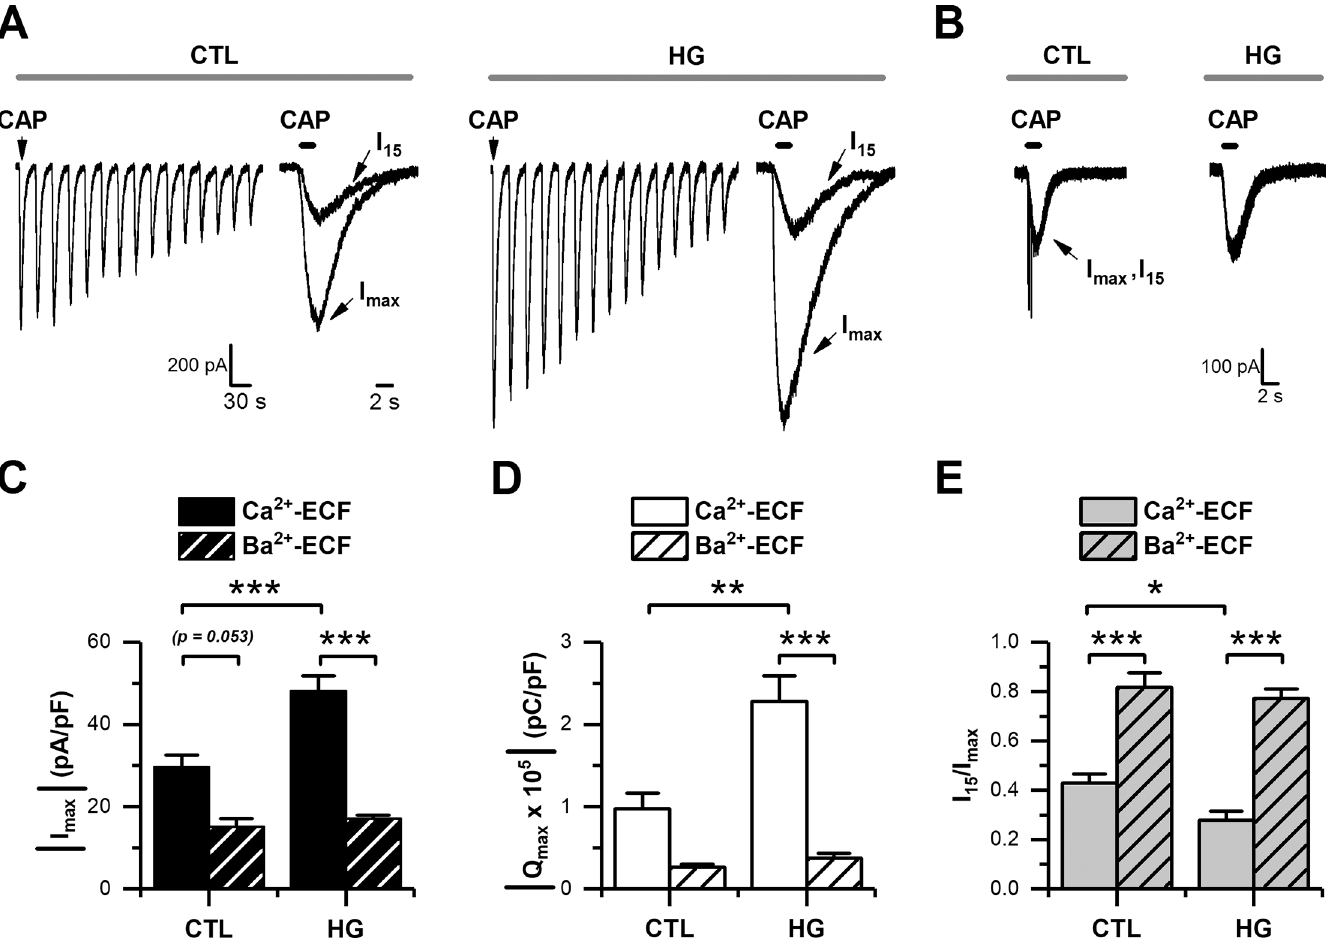
Fig 1. High glucose potentiated CAP-evoked currents in cultured DRG neurons. A-B, representative traces of CAP-evoked currents recorded in whole-cell voltage- clamp mode (holding potential set at -60 mV). Agonist was applied for 1 s and repeated every 30 s, in control (CTL), and high glucose (HG) in Ca 2+ -ECF (A), and in the same glucose conditions but in Ba 2+ -ECF (B), respectively. C-E, bar graphs summarizing maximal current (I max ) density (C), maximal current charge (Q max ; D), and maximal current rundown calculated as the ratio of I max relative to the 15 th application (I 15 ) in a series (E), for CTL (n = 24) and HG (n = 24) in Ca 2+ -ECF; and for CTL (n = 8) and HG (n = 11) in Ba 2+ -ECF, respectively. All data are represented as mean ± SEM. The absolute current density and charge were used in C and D for simplicity. Statistical analysis by two-way ANOVA followed by Sidak’s post-hoc test. (cid:3) , p < 0.05; (cid:3)(cid:3) , p < 0.01; (cid:3)(cid:3)(cid:3) , p <